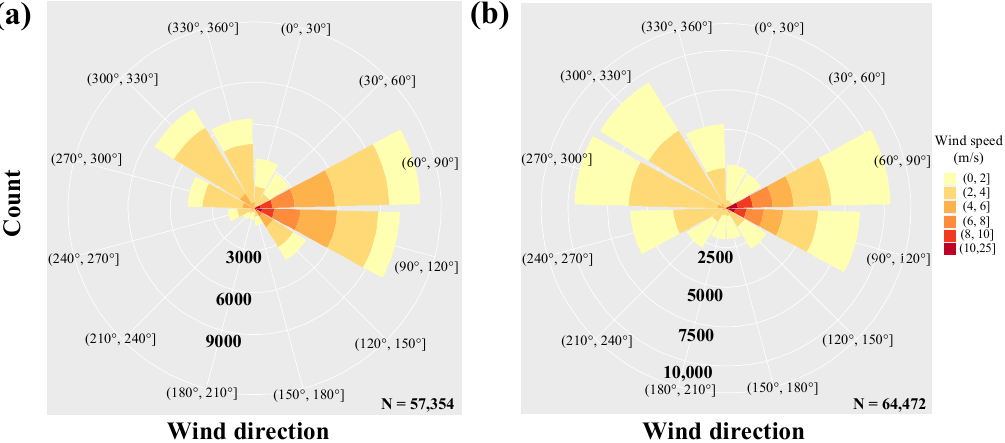
Figure 4. Wind direction and cumulative wind speed frequency during the ( a ) growing season and ( b ) dormant season. Colors represent wind speed bins.